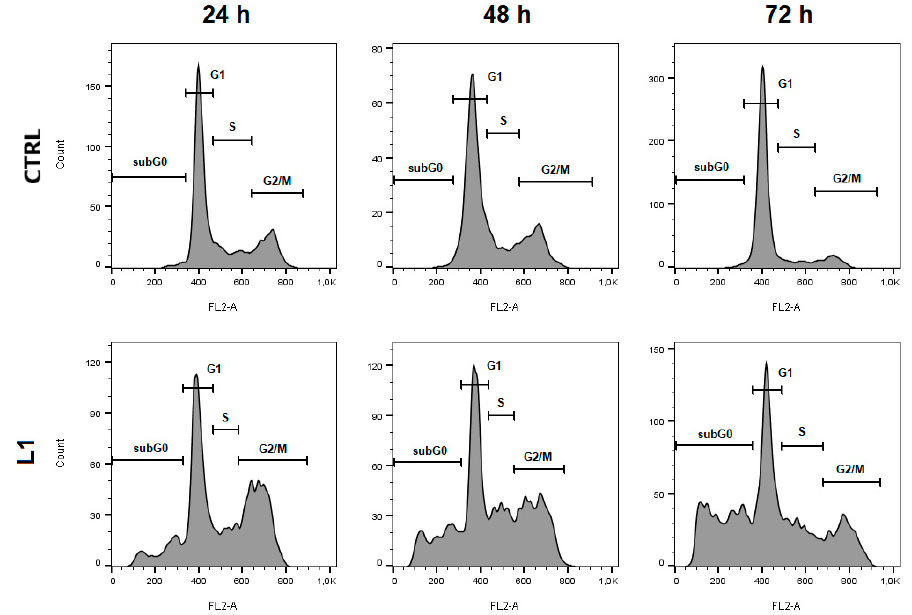
Figure 2. Histogram representation of cell cycle distribution in HeLa cells treated with L1 (10 µM) after 24 h, 48 h, and 72 h. Representative data of three independent experiments are presented. Table 1. Cell Cycle Analysis of HeLa Cells after 24 h, 48 h, and 72 h Incubation with L1.